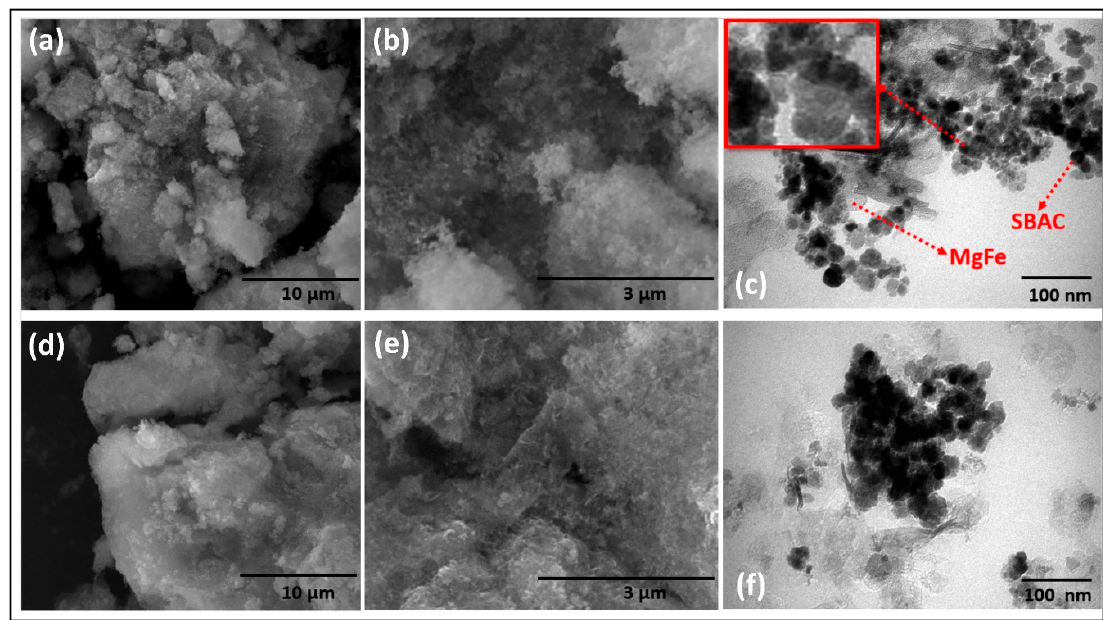
Figure 1. SEM images of SBAC 100 MgFe ( a , b ) and SBAC 500 MgFe ( d , e ) composites. TEM images of SBAC 100 MgFe ( c ) and SBAC 500 MgFe ( f ) composites.